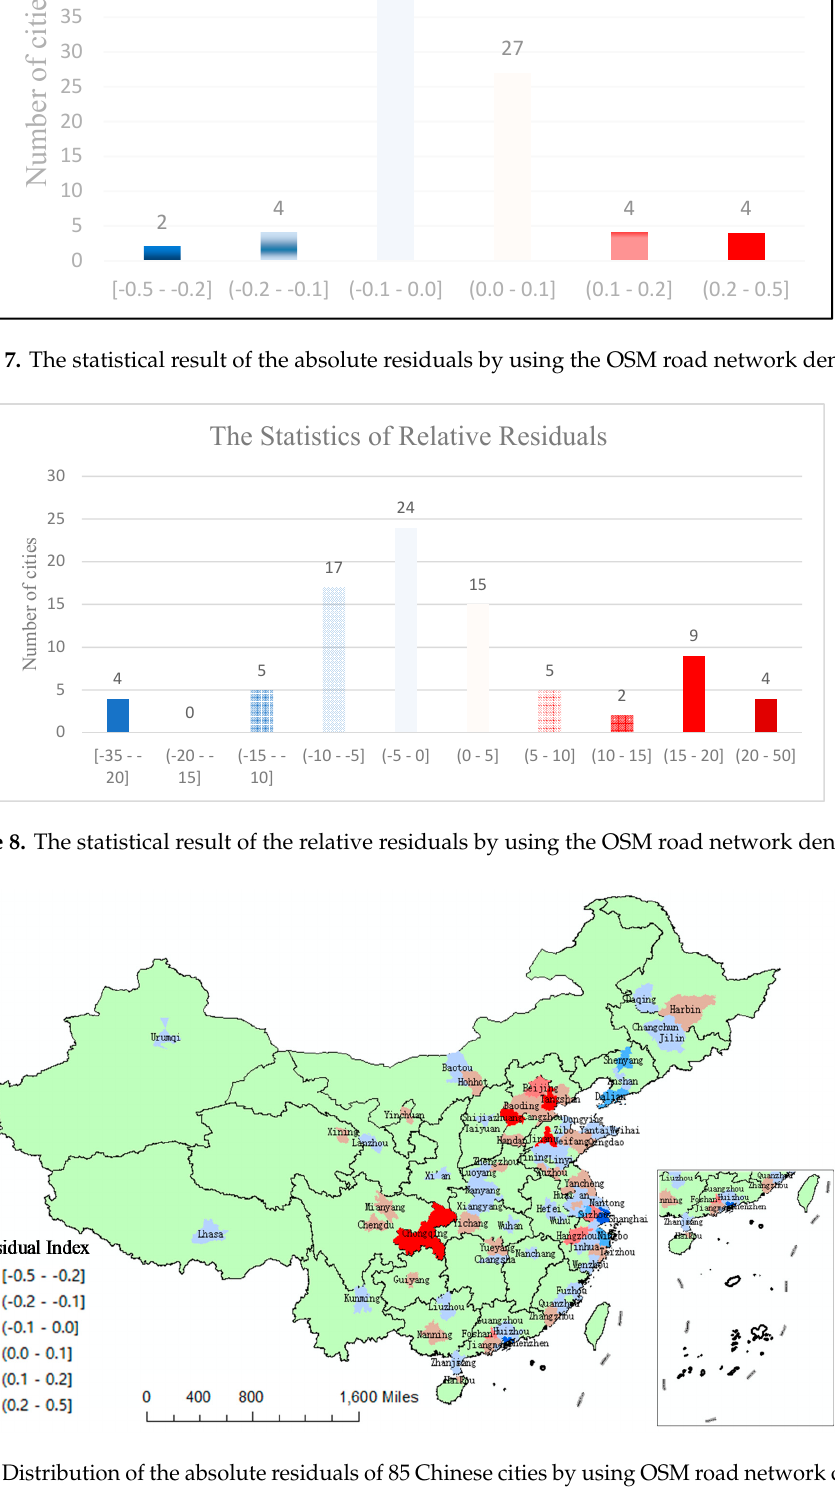
Figure 9. Distribution of the absolute residuals of 85 Chinese cities by using OSM road network